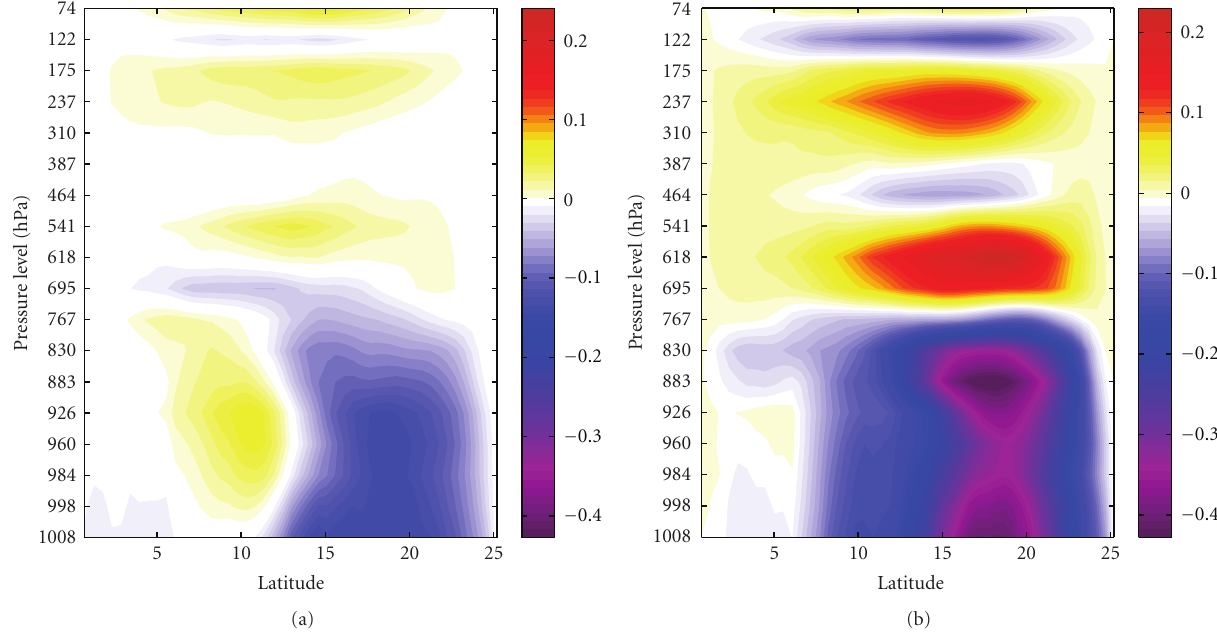
Figure 14: Meridian vertical profile of dust e ff ect on temperatures in ◦ C, averaged between 66 ◦ W and 23 ◦ E during the periods (a) MAM and (b) JJA. Cooling is indicated with cool colors while warming with hot colors.